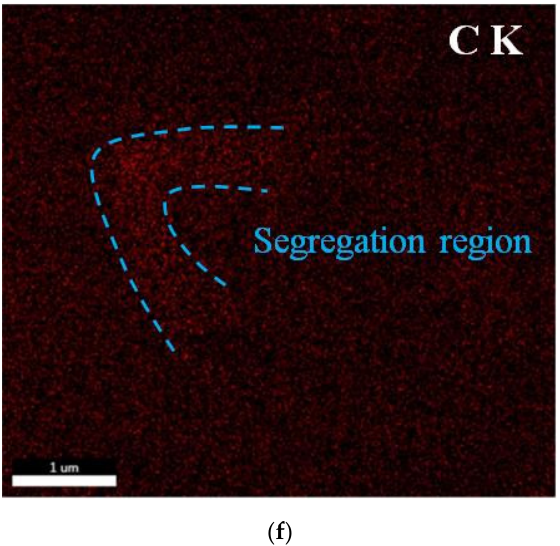
Figure 2. SEM, BSE and EDS images of the P91 steel aged at 625 °C: ( a ) SEM image for 3000 h, ( b ) the corresponding BSE image for ( a ) SEM image, ( c ) SEM image for 5000 h, ( d ) the corresponding BSE image for ( c ) SEM image, © EDS X-ray maps of selected area in ( e ) for Mo, Fe, Cr, Si, ( f ) EDS X-ray maps of selected area in ( c ) for C.